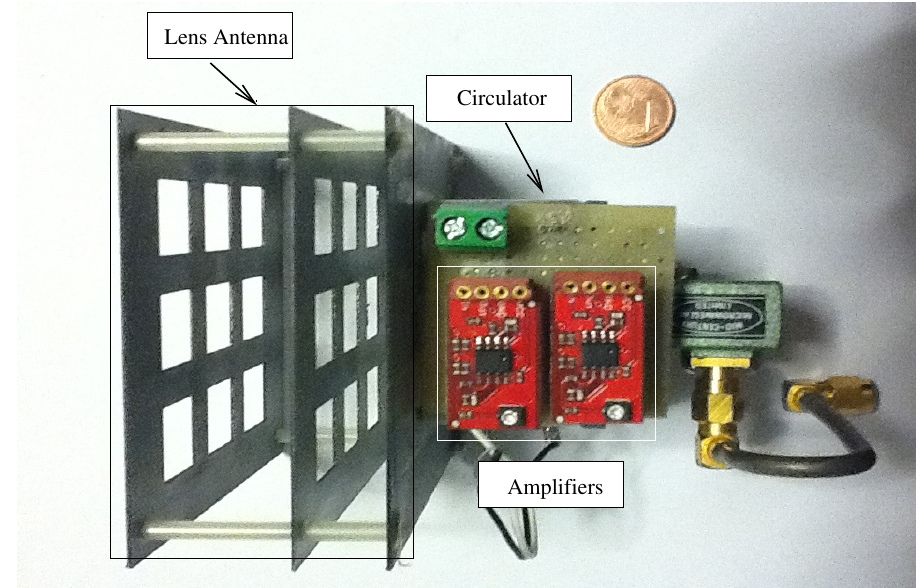
Figure 2. Photograph of the compact MST